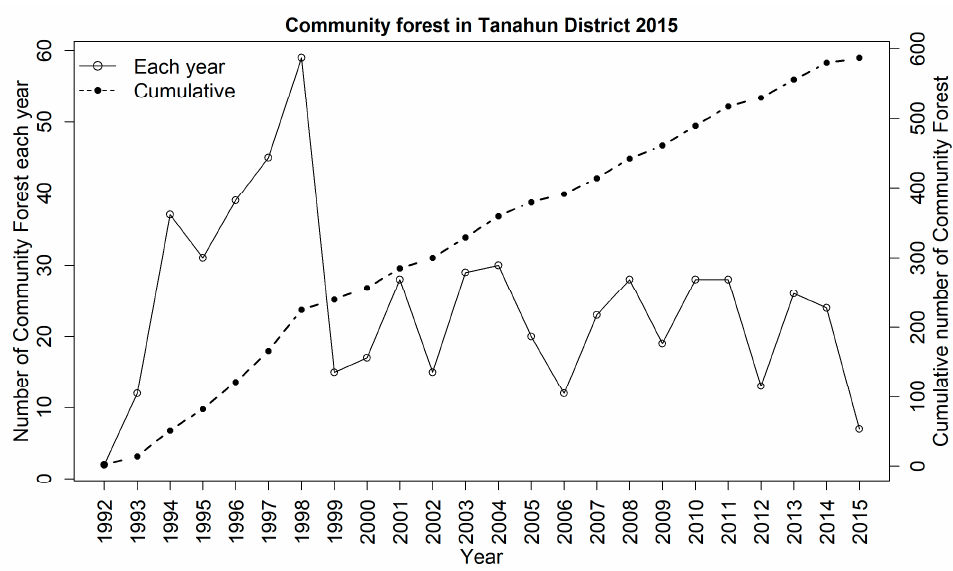
Figure 2. Trend of community forest handover in Tanahun District.